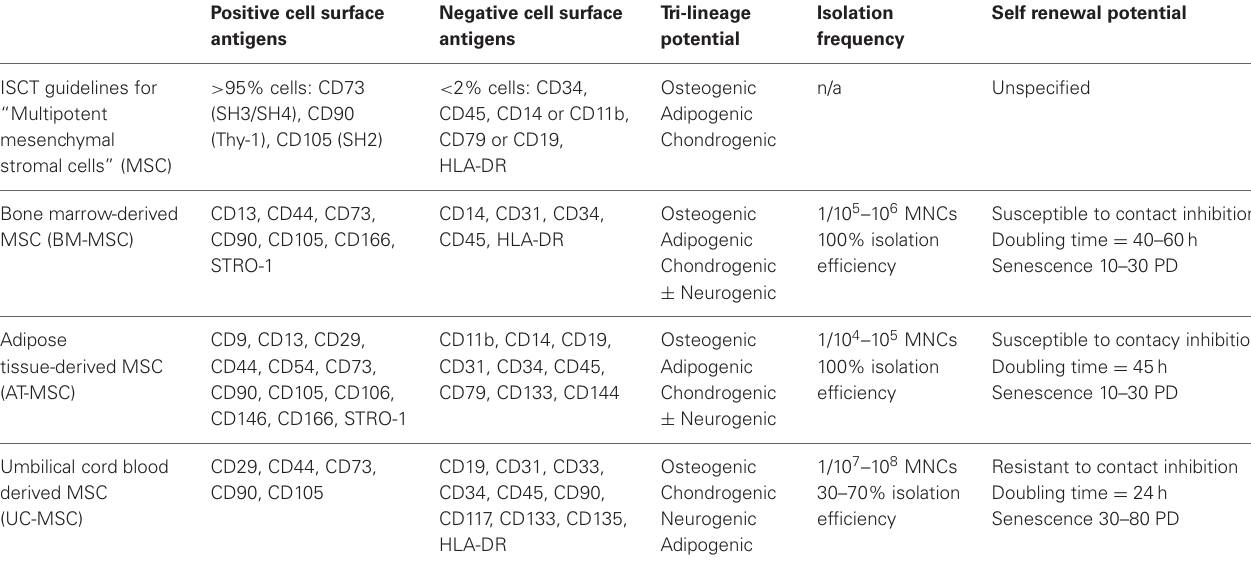
Table 1 | hMSC sources and biological